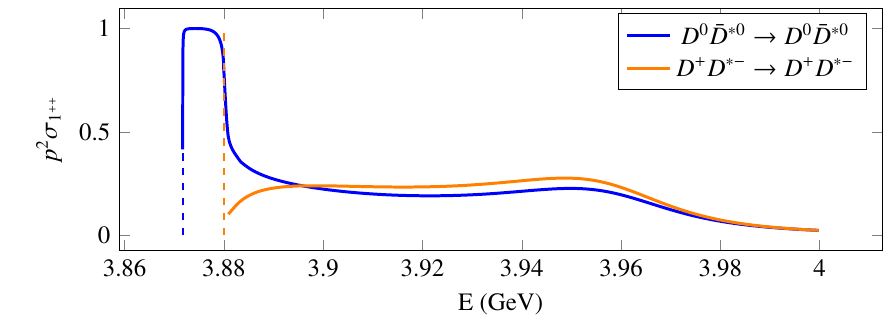
Figure 4. Calculated cross-sections for J PC = 1 ++ , scaled by the relative momentum squared.